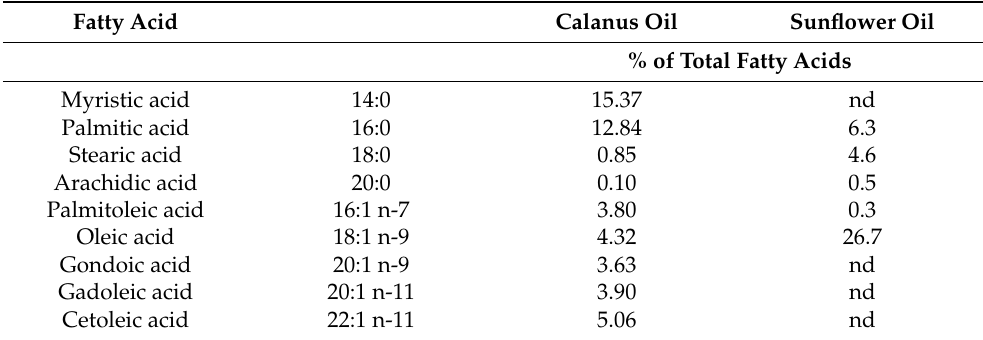
Table 1. Fatty acid composition of Calanus Oil and sunflower oil in the